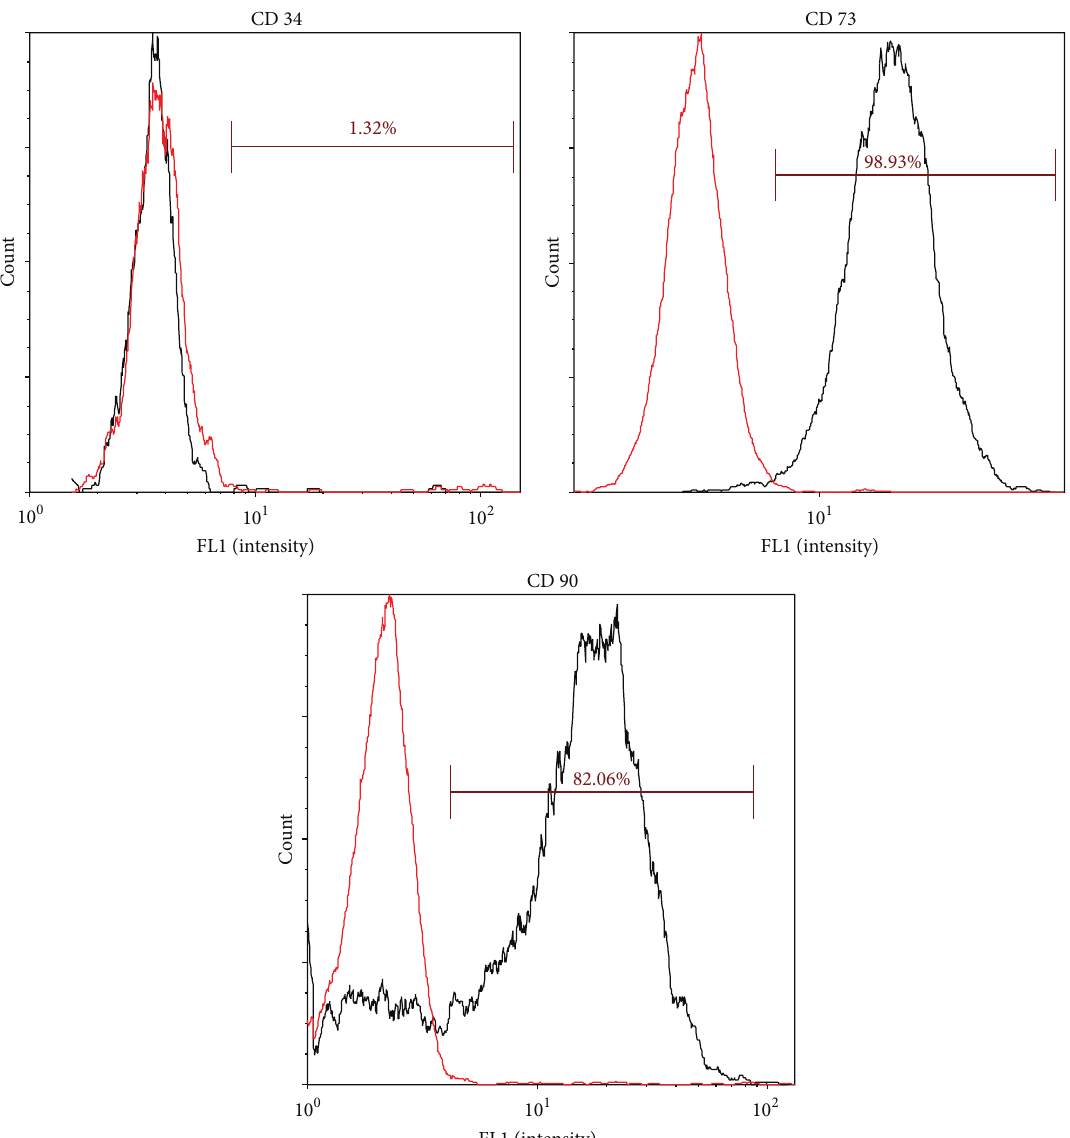
Figure 5: Immunophenotypical characterization of ASCs cultured in tPR. Passage 2 ASCs grown in tPR were positive for CD73 and CD90, mesenchymal stem cell markers, and were negative for CD34, a hematopoietic stem cell marker not typically found on passaged mesenchymal stem cells [25]. Black and red histograms represent specific and control antibody staining,